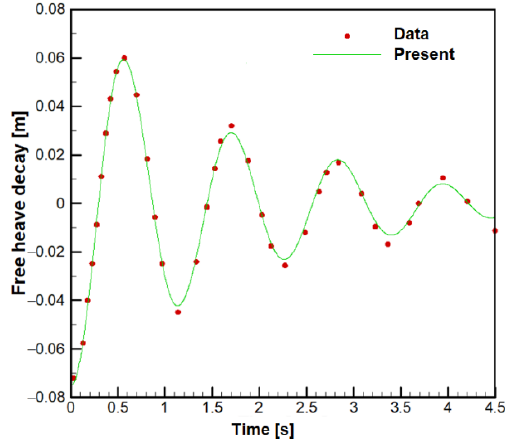
Figure 10. Free heave decay motions in still water.